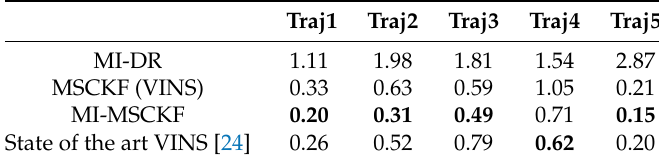
Table 1. Summary of final drift error on full dataset (% of trajectory length).